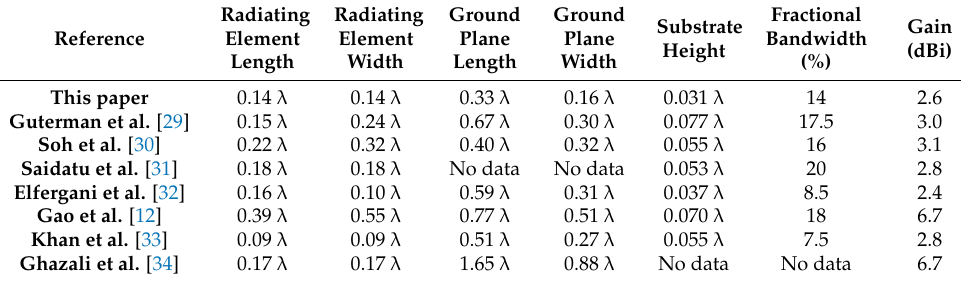
Table 2. Comparison with other designs.